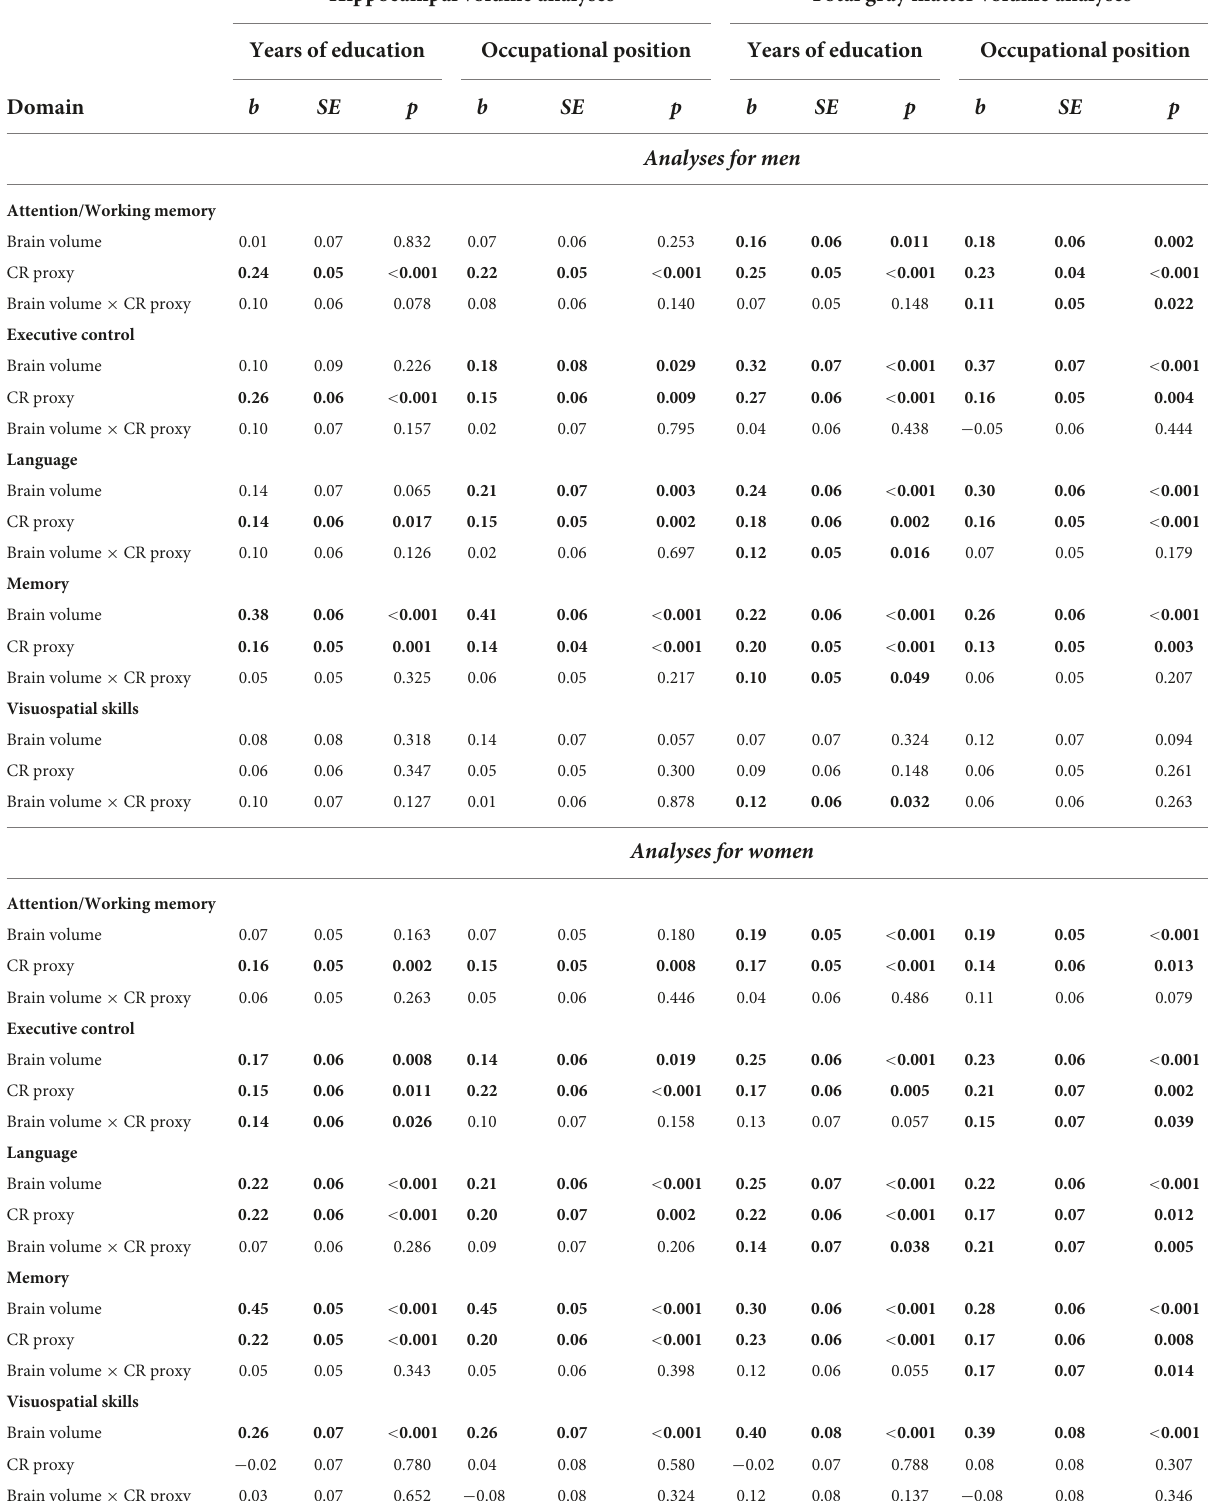
TABLE 6 Sensitivity moderation analyses for participants without dementia stratified by